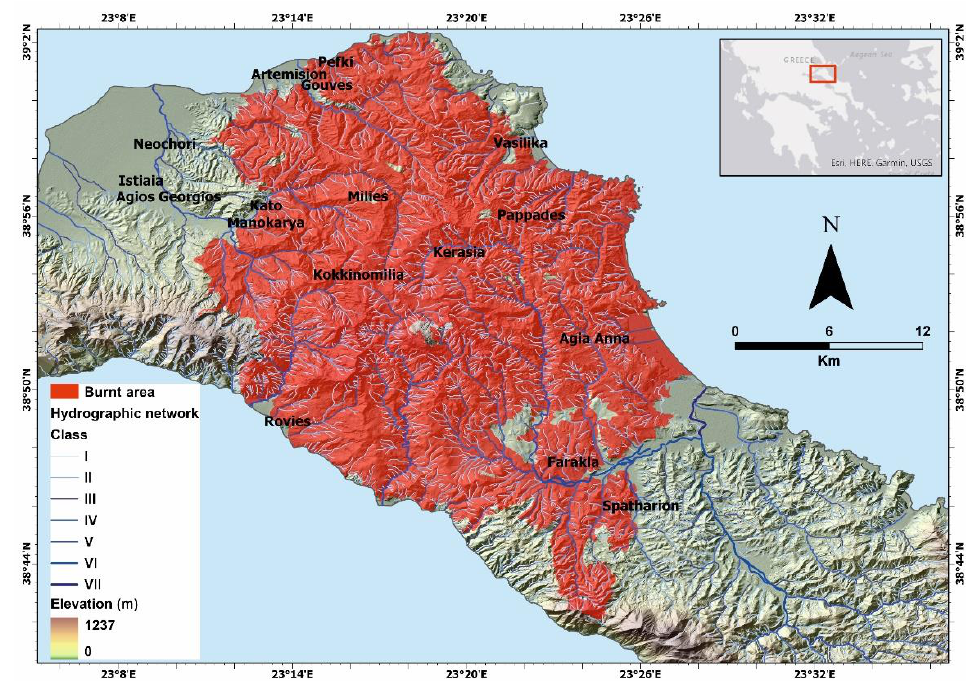
Figure 5. The fire affected area in Euboea along with the drainage network.